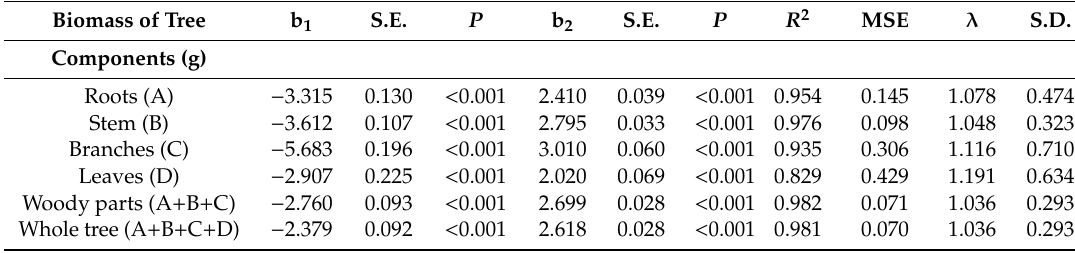
Table 6. Biomass models of individual tree components in common aspen using stem base diameter as an independent variable, showing their regression coe ffi cients (b 1 , b 2 ), standard errors (SE), p -values ( P ), coe ffi cients of determination ( R 2 ), mean squared errors (MSE), logarithmic transformation bias ( λ ), and standard deviation (SD) (see Equation